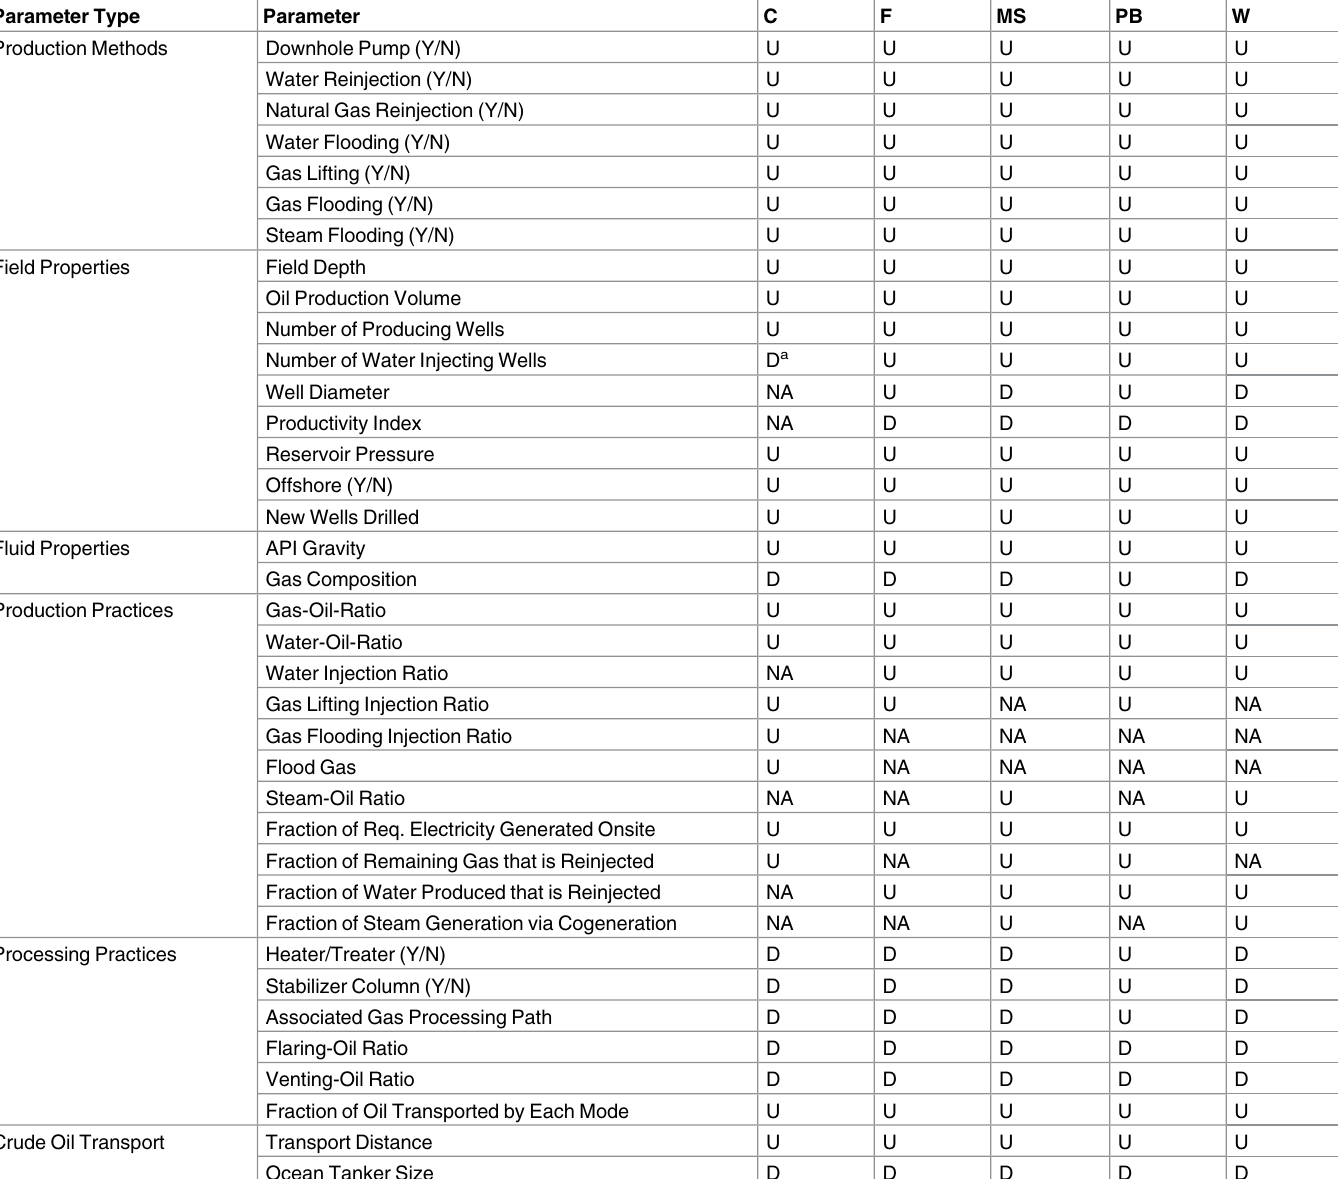
Table 3. Data classification for parameters in OPGEE’s main “Inputs” sheet: User-inputted (U) vs OPGEE default (D) (C = Cantarell, F = Forties, MS = Midway-Sunset, PB = Prudhoe Bay, W = Wilmington). User-inputted parameters are based on literatureor modeling assumptions. Parameter